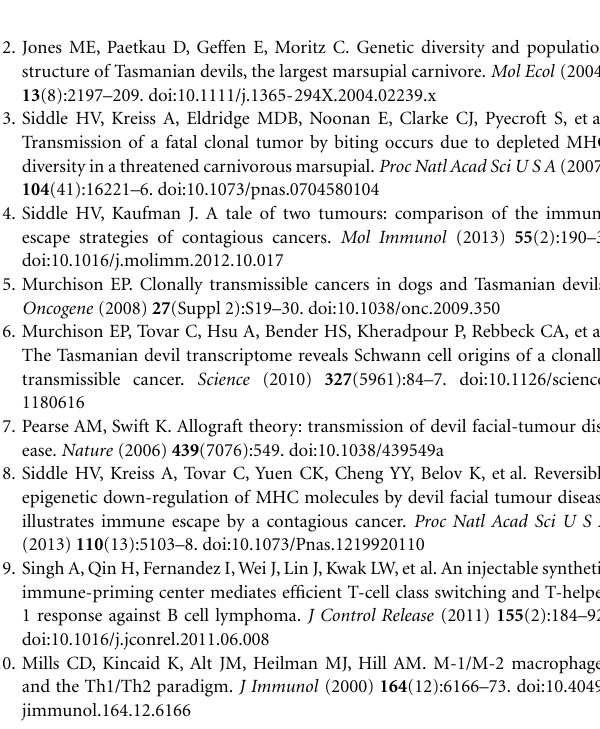
FIGURE 9 | Mice immunized with sonicated or freeze/thaw DFTD cells produced lower levels of anti-DFTD antibody and lower levels of IFN- γ andTNF- α compared to mice immunized with viable or